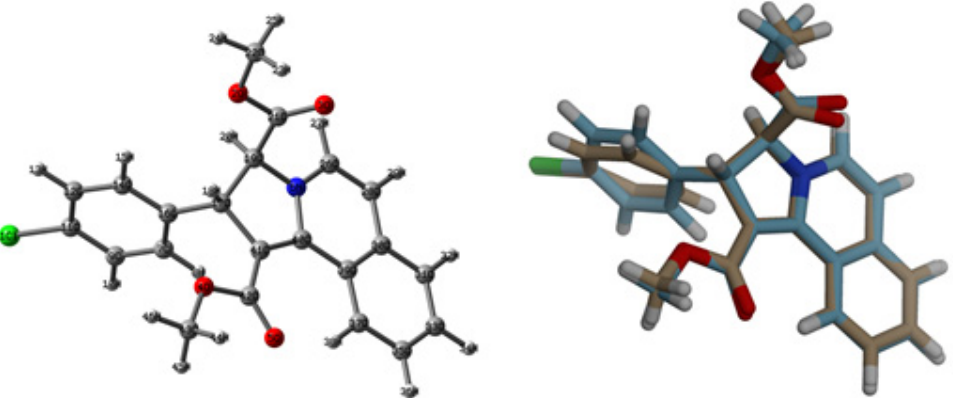
Figure 6. The calculated structure ( left ) and its overlay with experimental one, ( right ) for 3 .